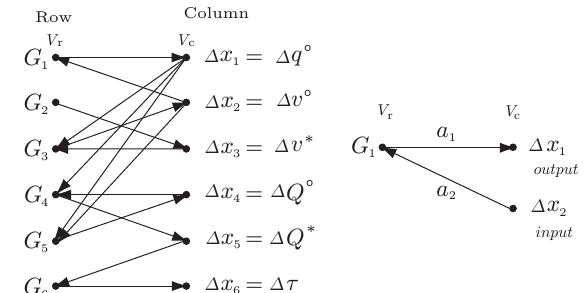
Figure 4. Causal Jacobian matrix.